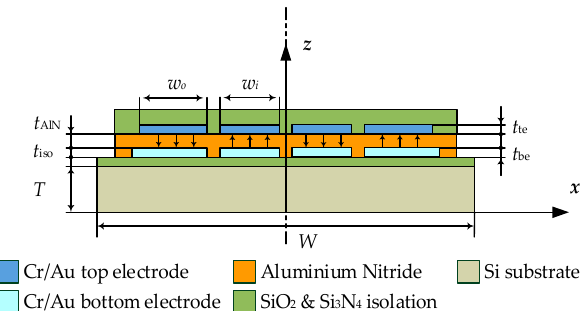
Figure 3. Schematic cross-sectional view on the micro-electromechanical system (MEMS) resonator illustrating the electrode design and the plate support of the 15-mode.